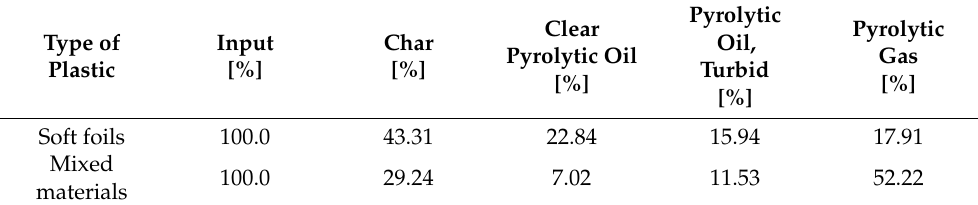
Table 6. Nitrogen migration in products.